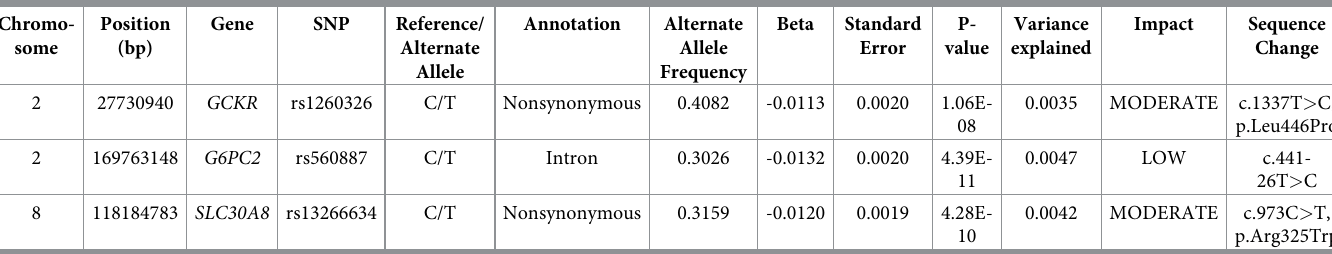
Table 1. Lead SNPs from discovery GWAS.